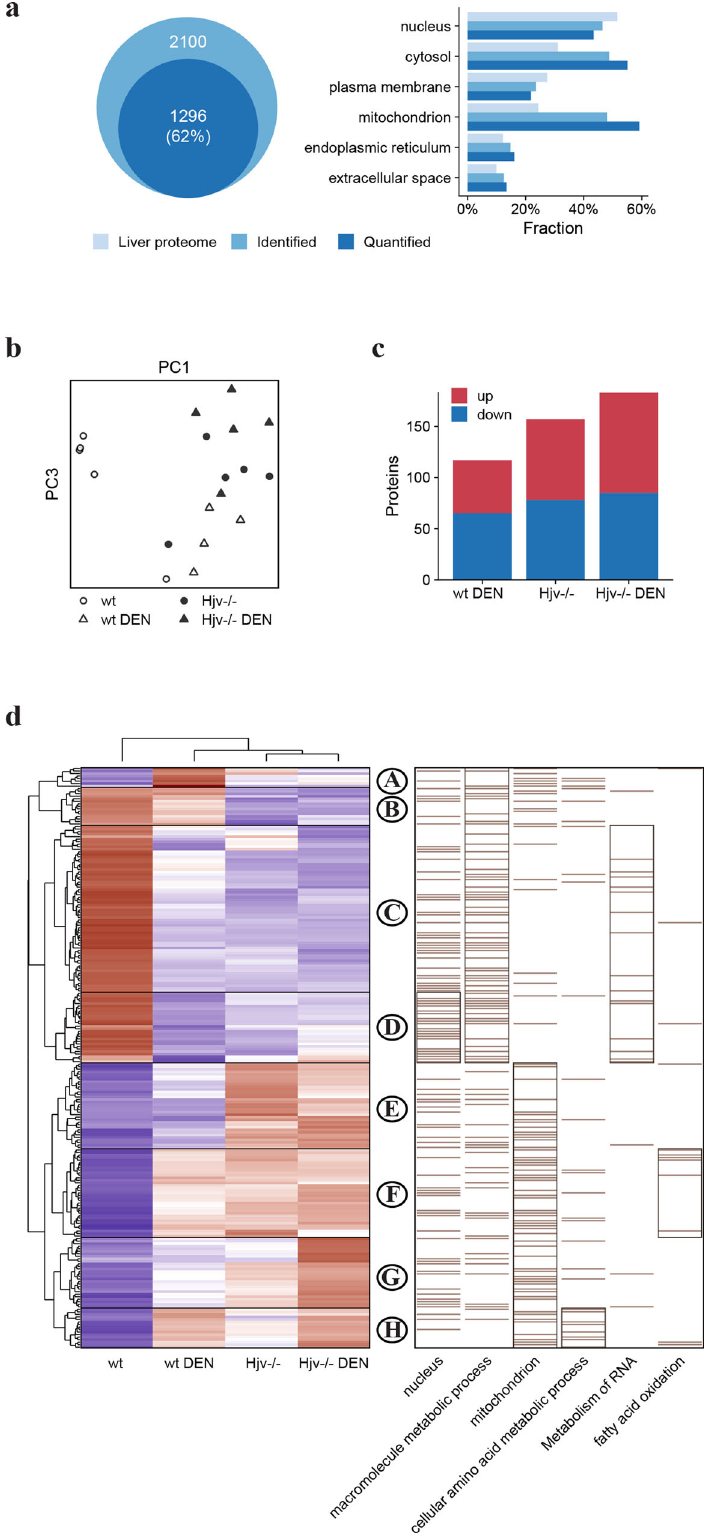
Fig. 2 Alterations in the liver proteome of wild type and Hjv − / − mice following DEN treatment. a Gene ontology analysis and subcellular distribution of quanti fi ed liver proteome compared to maximal detectable mouse liver proteome. b Principal component analysis (PCA) comparing the four mouse groups based on component 1 and 4, accounting for 26.6% and 7.6% of variability, respectively. c Number of differentially expressed proteins compared to wild type control mice. d Heat map of mean z-scored protein LFQ intensities of 230 differentially expressed proteins (ANOVA FDR < 0.05) after unsupervised hierarchical clustering. Enriched Gene Ontology terms among protein clusters are shown on the right. Bars represent position of annotated proteins; subclusters with highest enrichment (Fisher ’ s exact test p -value) for each term are